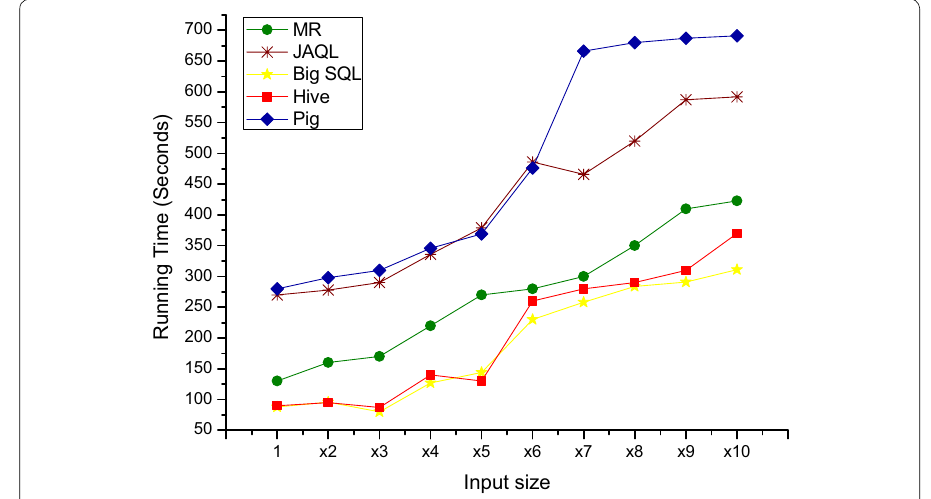
Fig. 9 Web log processing benchmark metric in increasing input size